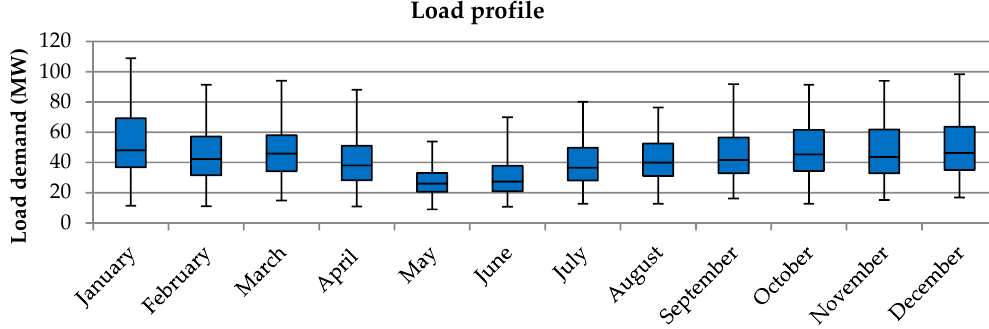
Figure 2. A twelve-month load profile of the study as a marketable figure.